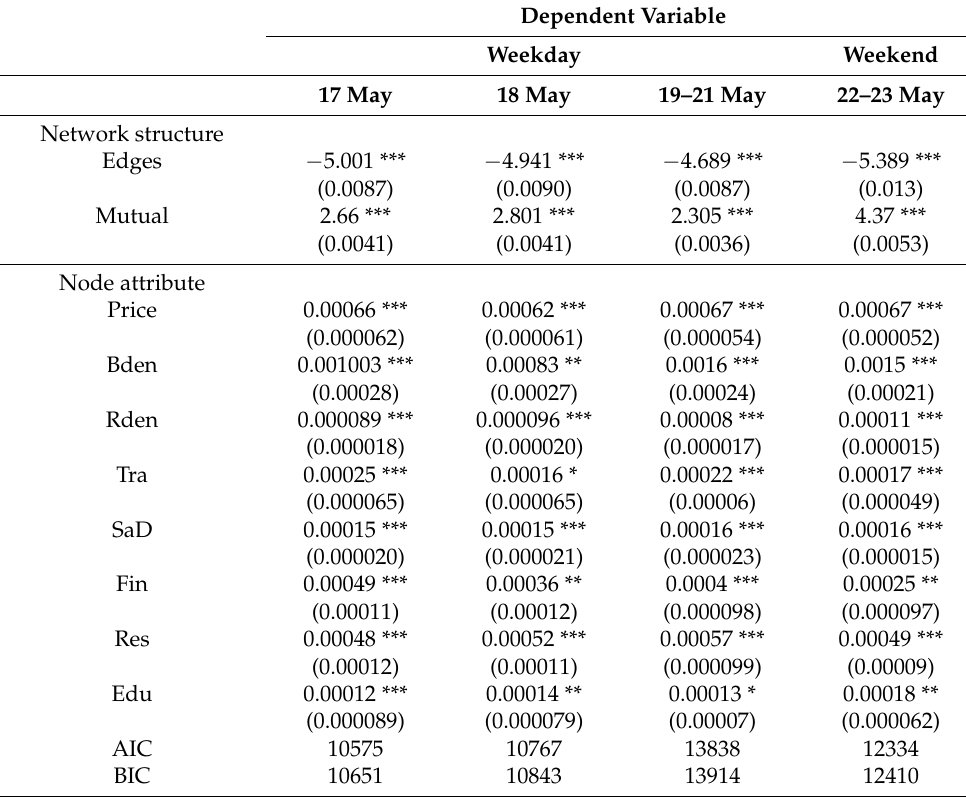
Table 6. Analysis of the influencing factors of the travel